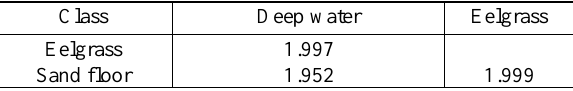
J-M distances computed for the eight original bands of the WV-2 image.